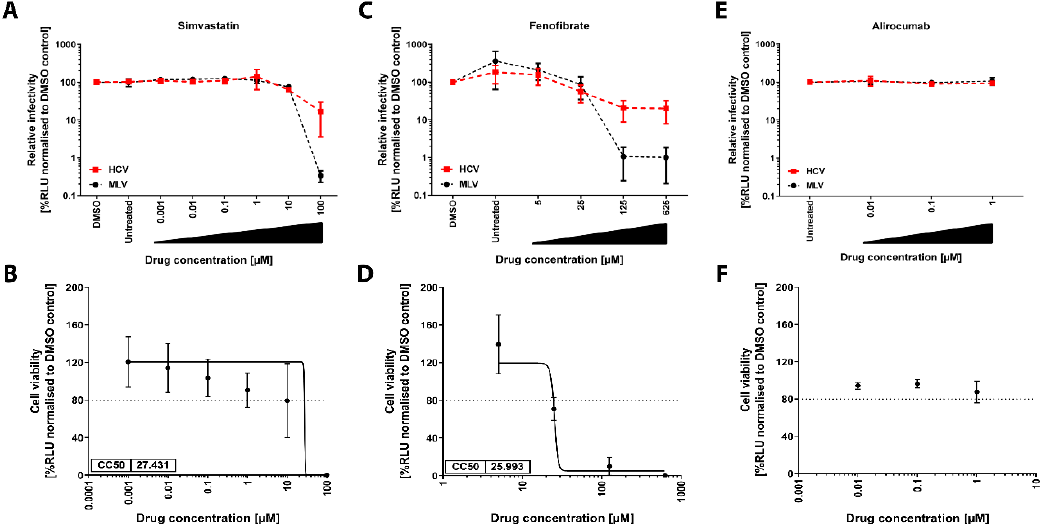
Figure 1. Lipid-lowering drugs (LLDs) do not affect Hepatitis C virus (HCV) genotype 1a entry into Huh-7.5 cells. Effect of LLD on HCV entry and cell viability. Dose-response of lentiviral pseudoparticle (pp) entry into Huh-7.5 ( A , C , E ). Cells were preincubated for 24 h with increasing concentrations of either simvastatin ( A ), fenofibrate ( C ), or alirocumab ( E ) before transduction with NLuc-encoding pps bearing E1-E2 GT1a glycoprotein (GP) (HCV), MLV env (MLV) for 6 h. NLuc activity was measured 72 h post-transduction (hpt) and luciferase activity was normalized to solvent control. MLVpp entry served as virus control. Drug-induced cytotoxicity ( B , D , F ). Huh-7.5 cells constitutively expressing NLuc (Huh-7.5/NLuc) were treated with either simvastatin ( B ), fenofibrate ( D ) or alirocumab ( F ) for 30 h as for ( B , D , F ) but were not transduced. Ninety-six h after treatment, NLuc activity was measured and luciferase activity values were normalized to DMSO control. When determined, CC50 values were indicated at the lower left side of the graph. Graphs represent the average of three independent experiments performed in triplicate with error bars representing the standard deviation (SD).